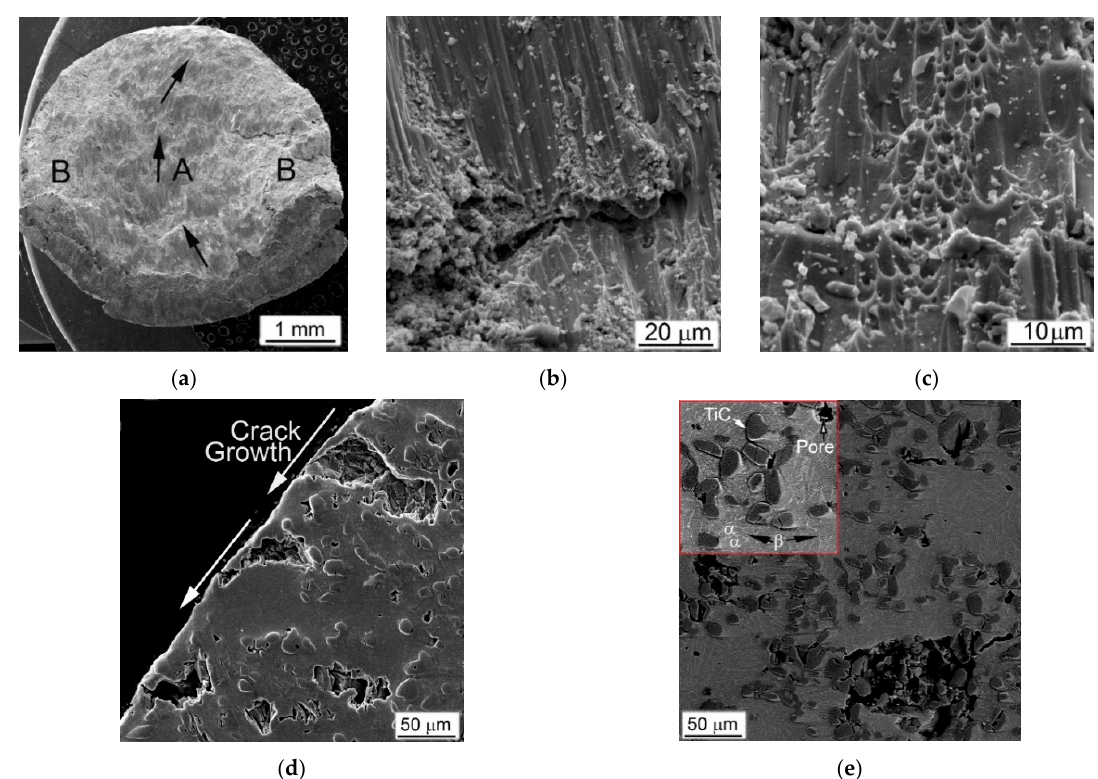
Figure 13. Fracture surface ( a – c ) and microstructure ( d , e ) of Ti64BEPM + 20TiC sample, SHPB tested with rate 1470 s − 1 . Arrows in ( a , d ) indicates directions of cracks growth. ( d ) Zone II; ( e ) Zone IV. SEM, ( a – c ) SE, ( d , e ) BSE images.